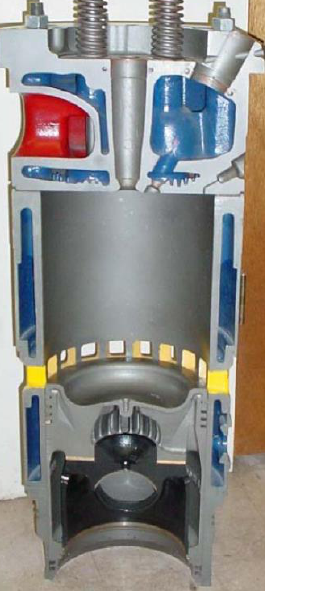
Fig. 2. EMD 645-E power assembly